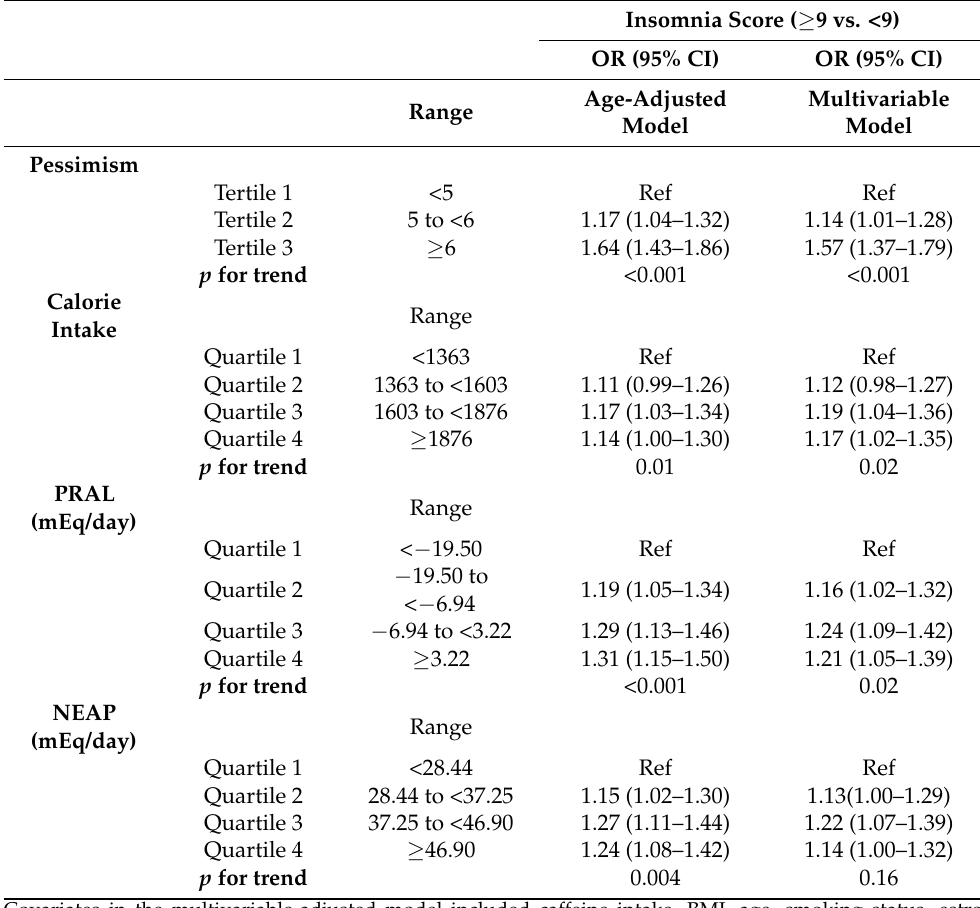
Table 5. Pessimism, total calorie intake, and dietary acid load in relation to insomnia.